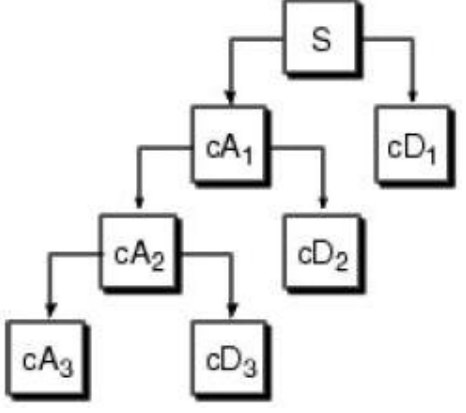
Figure 2. The process of discrete wavelet transform (DWT) (from Matlab’s Wavelet Toolbox Tutorial). The time-series (S) is decomposed into three